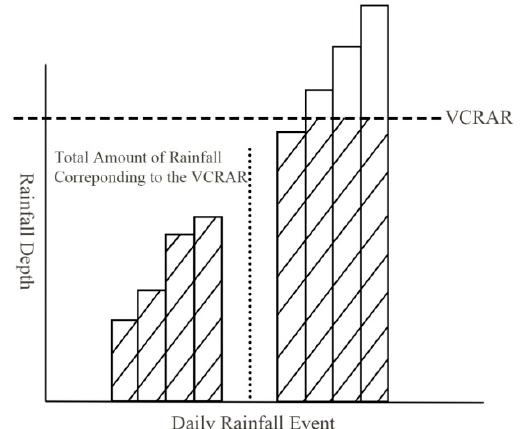
Figure 3. The statistical relationship between the VCRAR and the design rainfall depth (The x -axis is the daily rainfall events in the period of at least thirty years, in ascending order of daily rainfall amount).